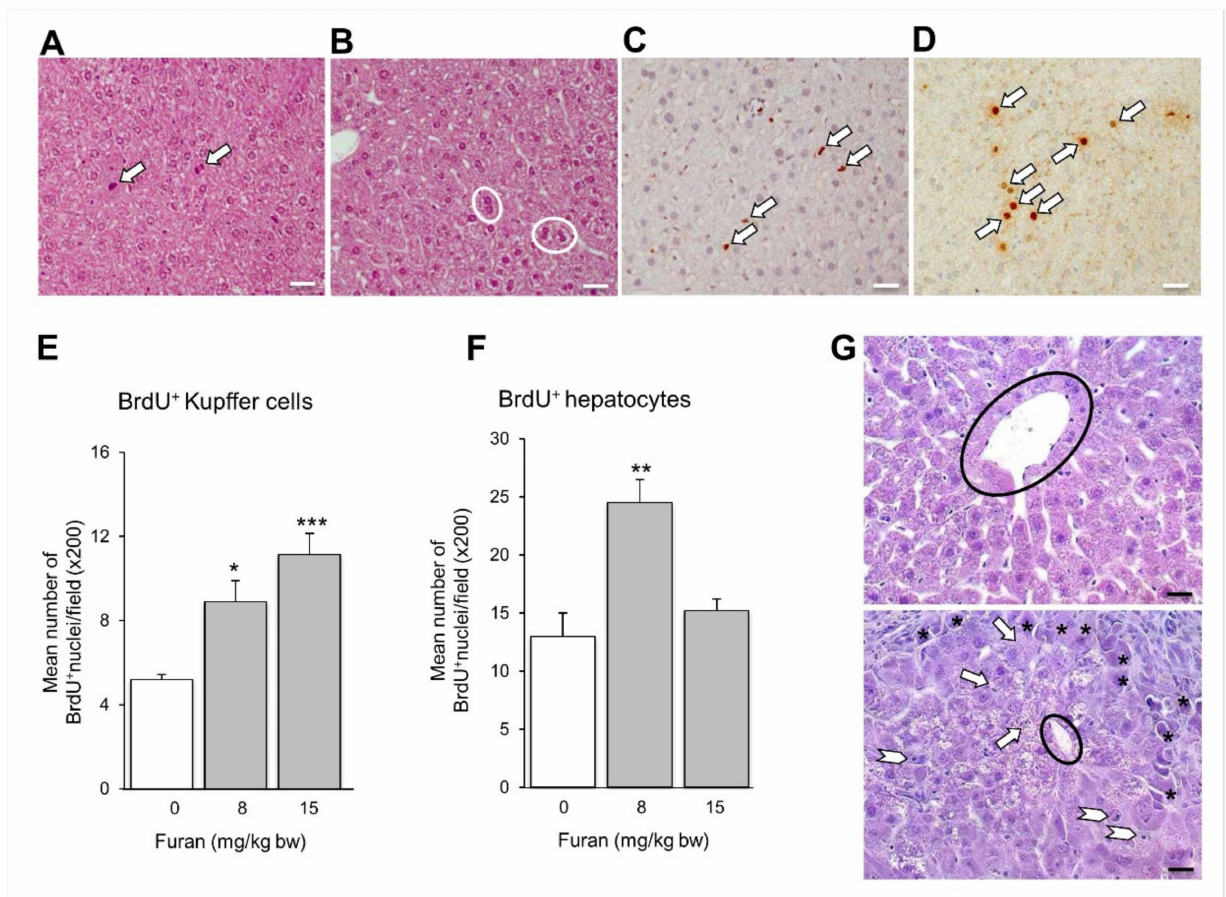
Figure 6. Immunopathological features of liver damage associated with furan administration. H&E staining shows the presence of mitoses (arrows in ( A )) and binucleated hepatocytes (circles in ( B )) after the administration of low-dose furan. Intranuclear accumulation of BrdU highlights the increased proliferative activity of Kupffer cells (arrows in ( C ), data in ( E )) and hepatocytes (arrows in ( D ), data in ( F )). ( G ) H&E staining shows the signs of severe liver damage which follows the administration of high-dose furan ( bottom ) compared to normal tissue ( top ): fatty degeneration (arrows), apoptotic figures (arrowheads) and frequent necrotic hepatocytes at the periphery of the lobule (asterisks). Black circles: central veins. * p = 0.0140, ** p = 0.0056, *** p = 0.0008, Student’s t -test vs. 0. Magnification: ( A – D ), × 400; ( G ), × 630. Scale bars ( A – D ): 20 µ m; ( G ): 10 µ